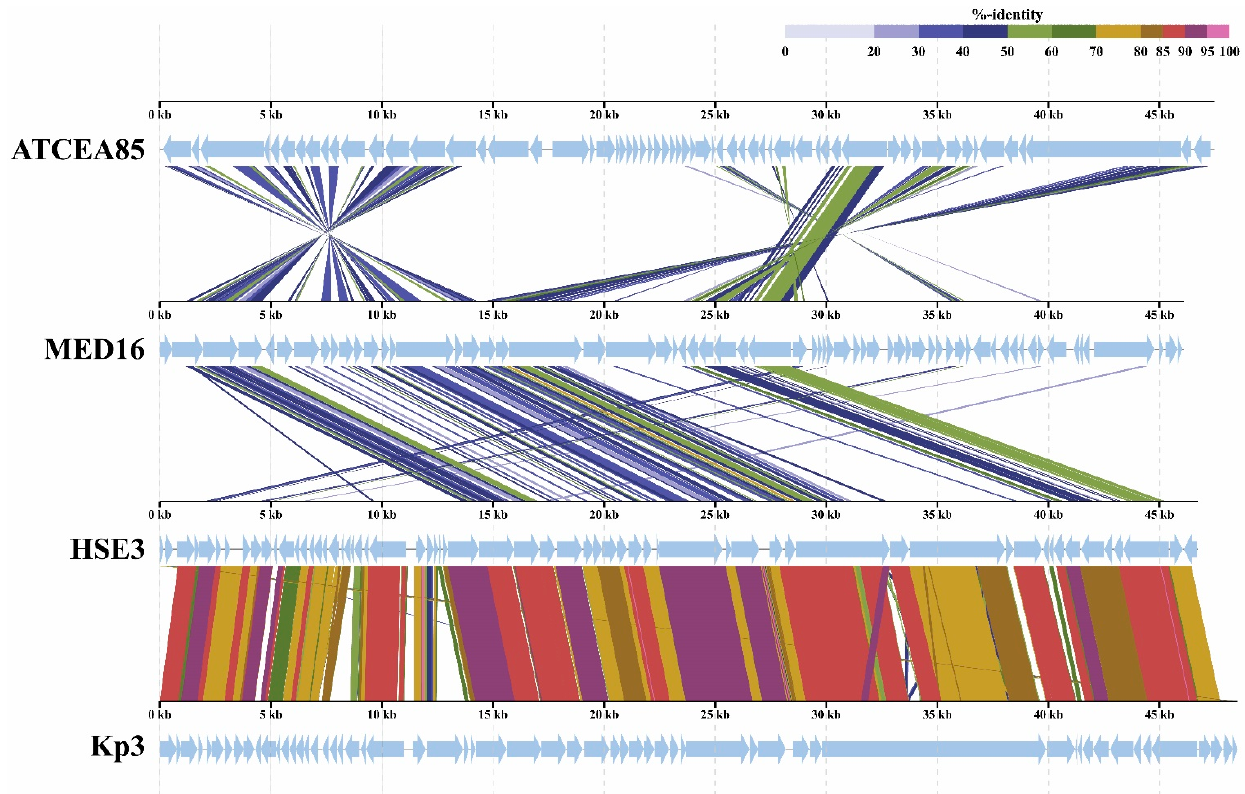
Figure 8. ViPTree generated whole-proteome alignment of Pantoea phage vB_PagS_MED16 and its closest relatives: Klebsiella phages vB_KleS-HSE3, Kp3 and Enterobacter phage ATCEA85. Colored lines in the alignment indicate tBLASTx results (E-value < 1 × 10 − 2 ). Positions of each sequence were automatically adjusted (i.e., circularly permuted and reverse stranded) for a clear representation of collinearity between genomes.